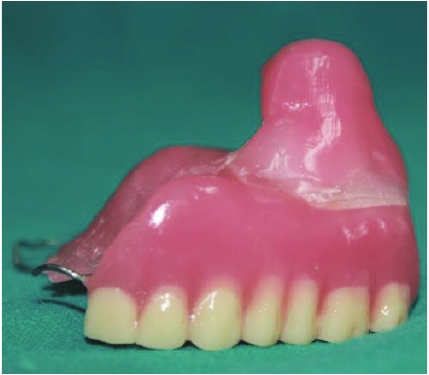
Figure 10: Final prosthesis.